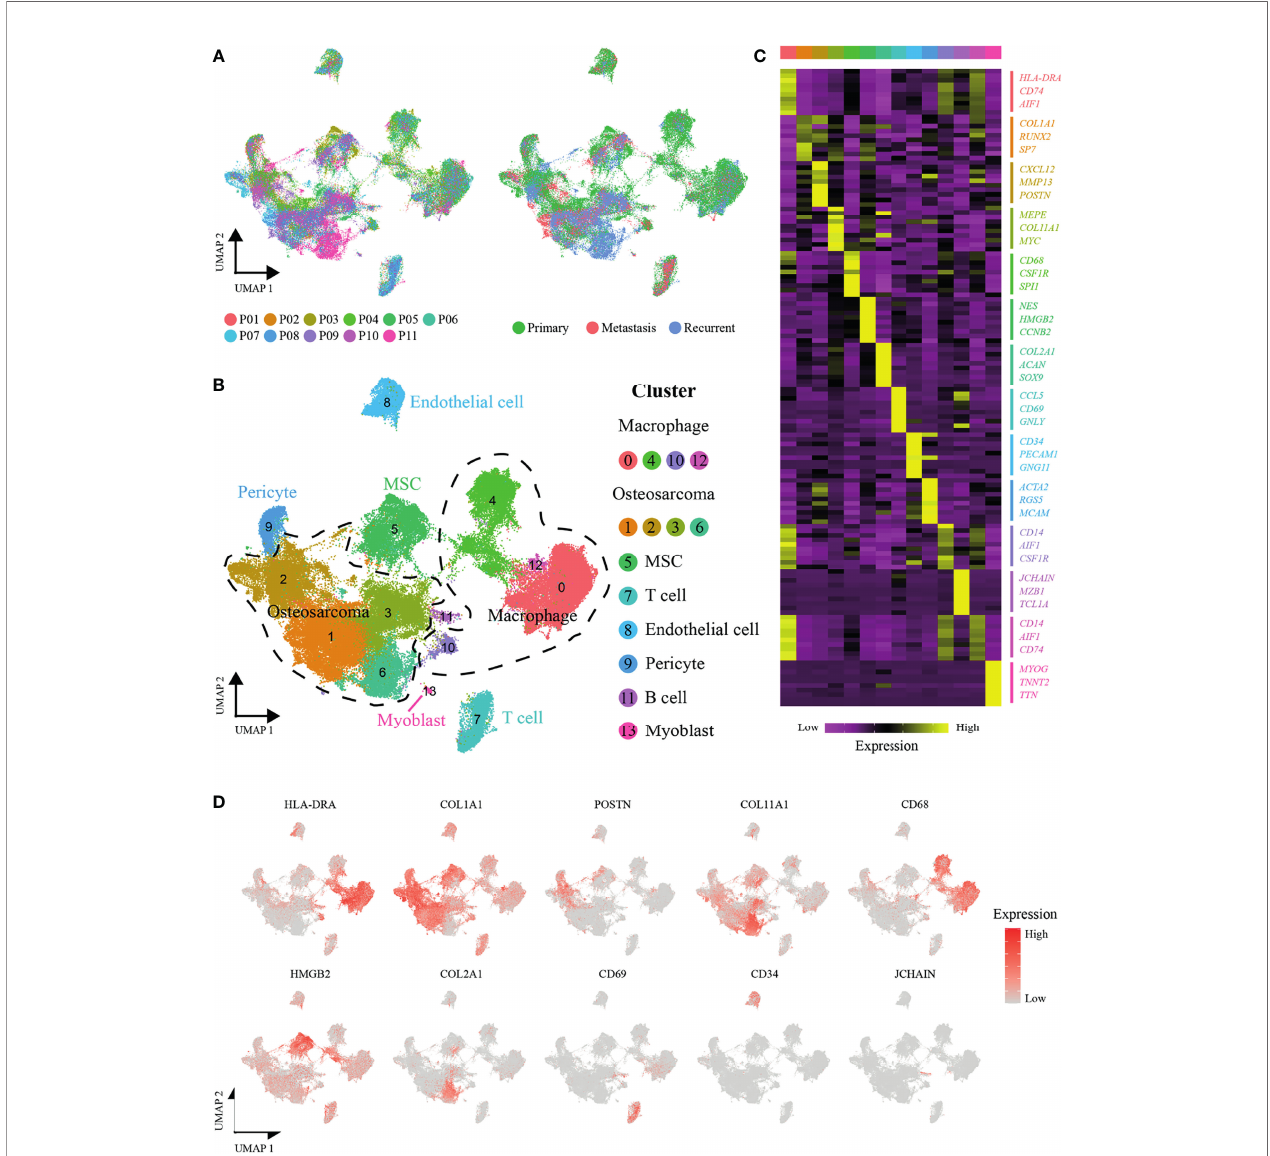
FIGURE 1 | scRNA-seq pro fi ling of OS tumor microenvironments. (A) Uniform manifold approximation and projection (UMAP) visualization of cells clustered and color-coded according to the patient (left panel) or disease state (right panel). (B) UMAP plot showing annotated and color-coded cell types in the OS microenvironment. (C) Heatmap showing the expression of marker genes in the indicated cell types. The top bar color indicates the speci fi c cell type cluster. (D) UMAP plot showing expression levels of marker genes for speci fi c cell